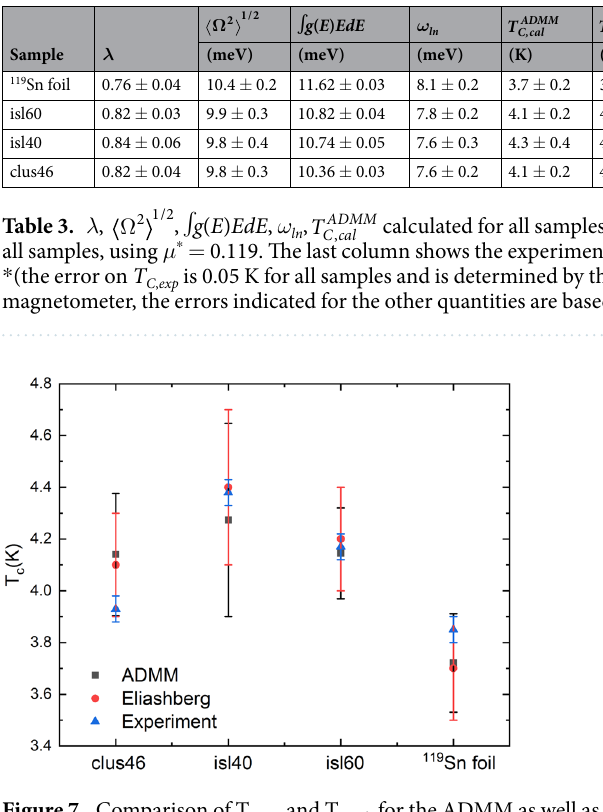
Figure 7. Comparison of T C , exp and T C , calc for the ADMM as well as the Eliashberg